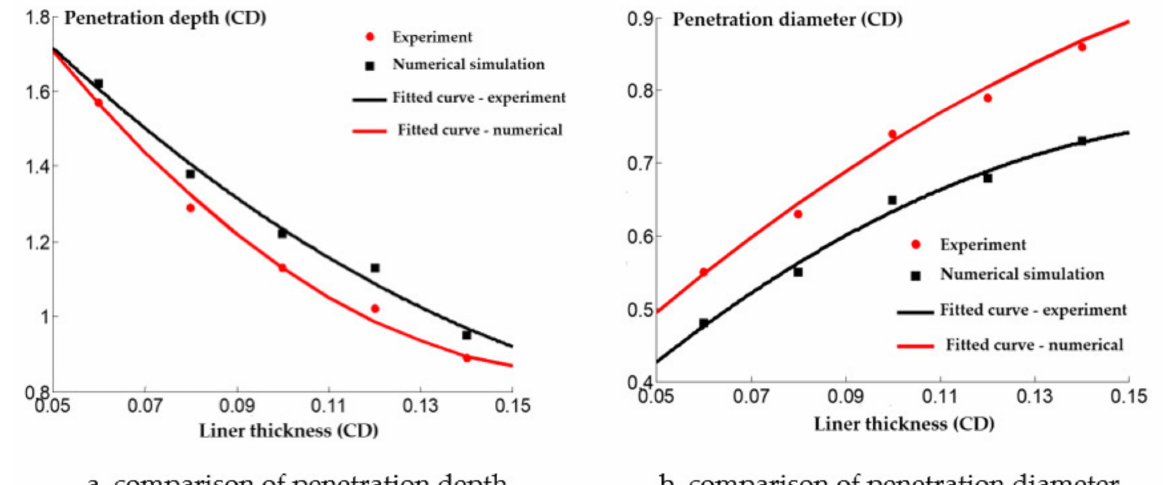
Figure 17. Comparison of numerical simulation and experimental results. In summary, the smaller the wall thickness of the reactive charge liner, the better the penetration ability of the reactive jet. However, the reactive charge liner itself is an energetic liner, and the implosion reaction occurs during the penetration process. The power of the implosion mainly depends on the mass of the reactive charge liner. When the wall thickness of the reactive charge liner is too small, the mass of the reactive charge liner is small, and the explosion effect in the perforation will be weakened. In this study, the reactive charge liner with a wall thickness of 0.1 times the charge diameter was selected as the research